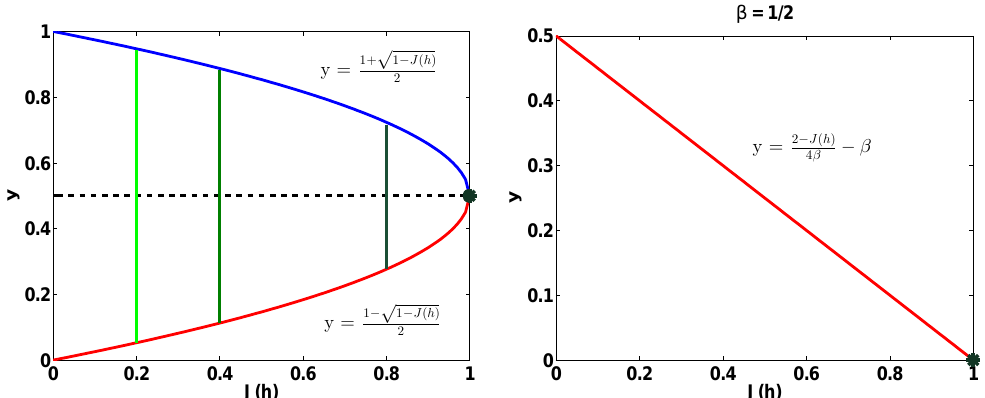
Figure 2. Left : Blue curve captures the behavior of the upper-bound on the balancing factor as a function of J ( h ) , red curve captures the behavior of the lower-bound on the balancing factor as a function of J ( h ) , green intervals correspond to the intervals where the balancing factor lies for different values of J ( h ) . Right : Red line captures the behavior of the upper-bound on the purity factor as a function of J ( h ) when the balancing factor is fixed to 1 . Figure should be read in 2